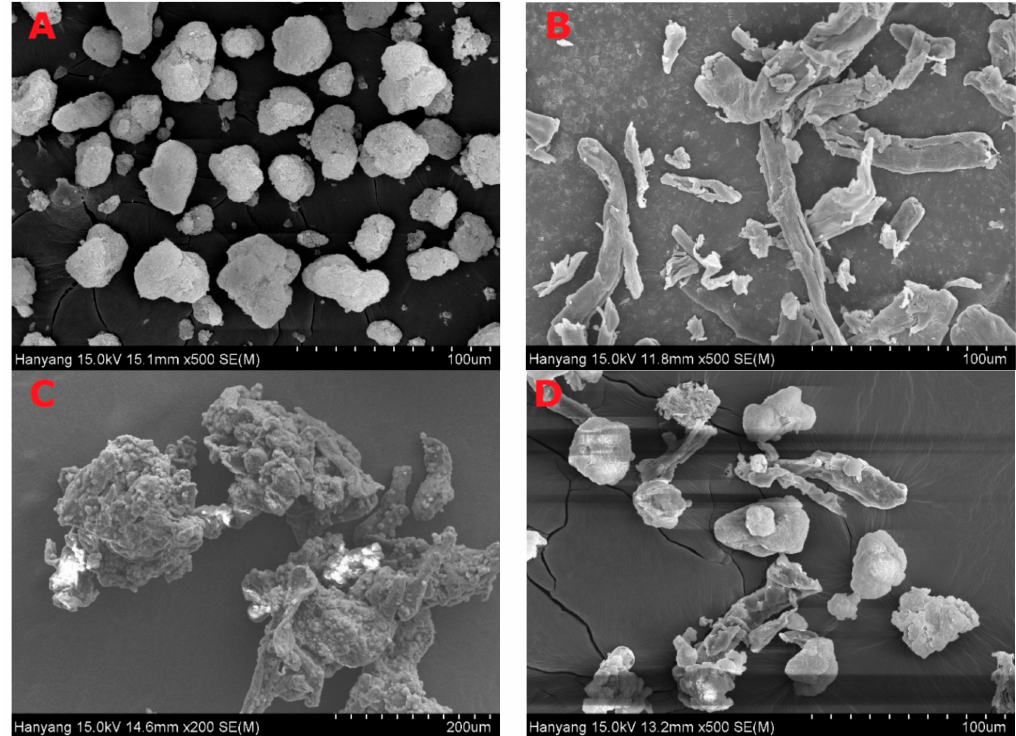
Figure 6. Scanning electron micrographs; ( A ) calcium silicate; ( B ) MCC; ( C ) SEGS; ( D ) solid self-nanoemulsifying drug delivery system